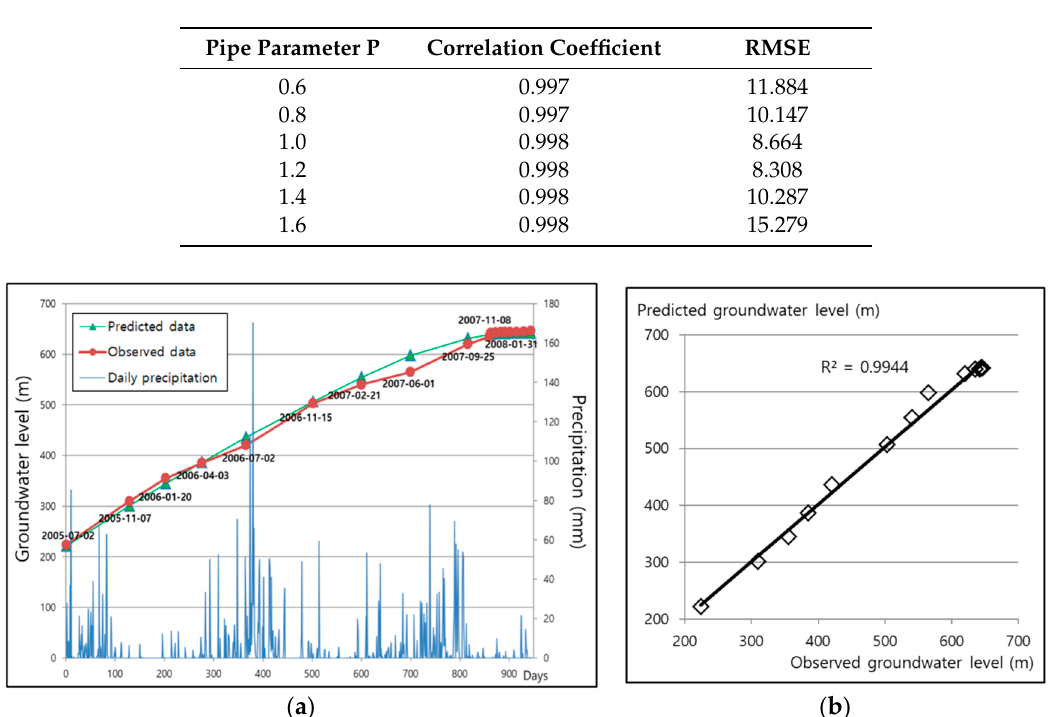
Figure 8. Mine maps of the Dongwon coal mine and surrounding mines. Table 4. The result of correlation coefficients and RMSE between simulated and observed groundwater levels according to pipe parameter of the Dongwon coal mine.